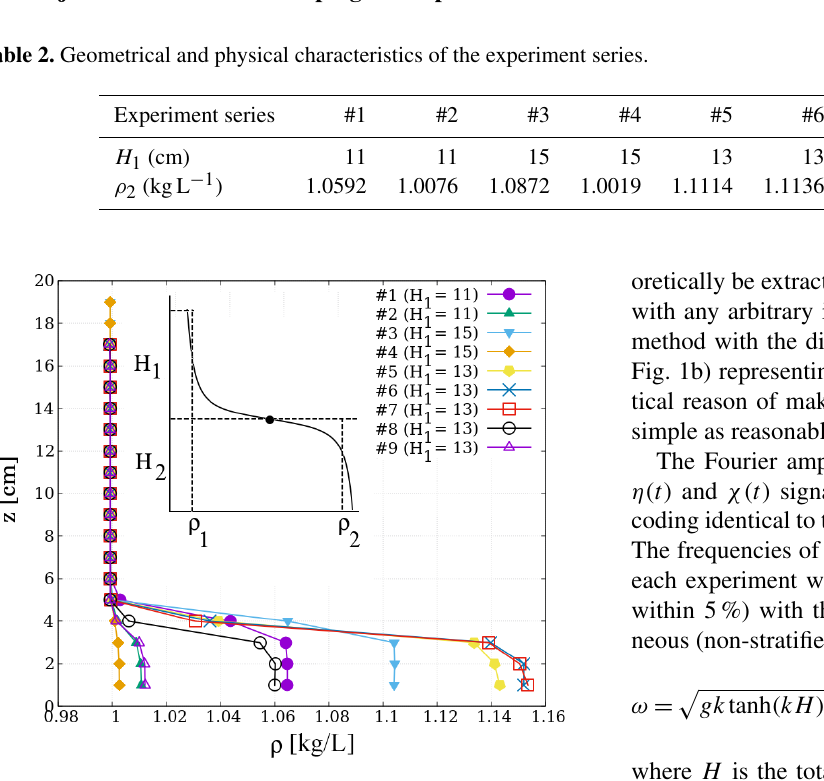
Figure 2. Density ρ as a function of vertical position z from the bottom for all experiment series (cf. Table 2). The sketch in the inset demonstrates the meaning of the parameters in the two-layer approximation.